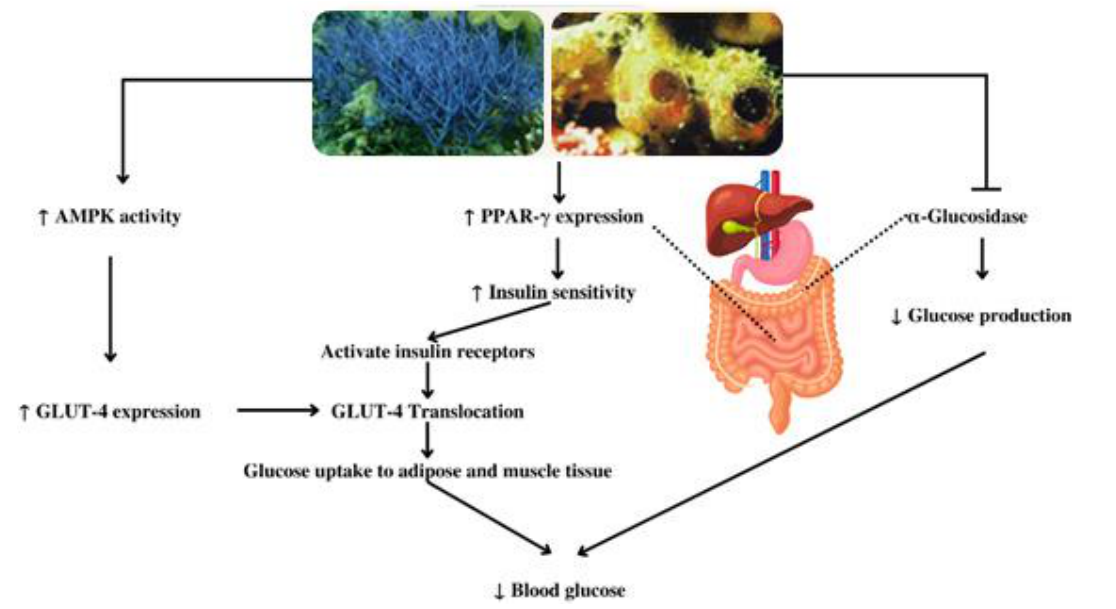
Figure 4. Antidiabetic mechanism of secondary metabolites from the subgenus Callyspongia .